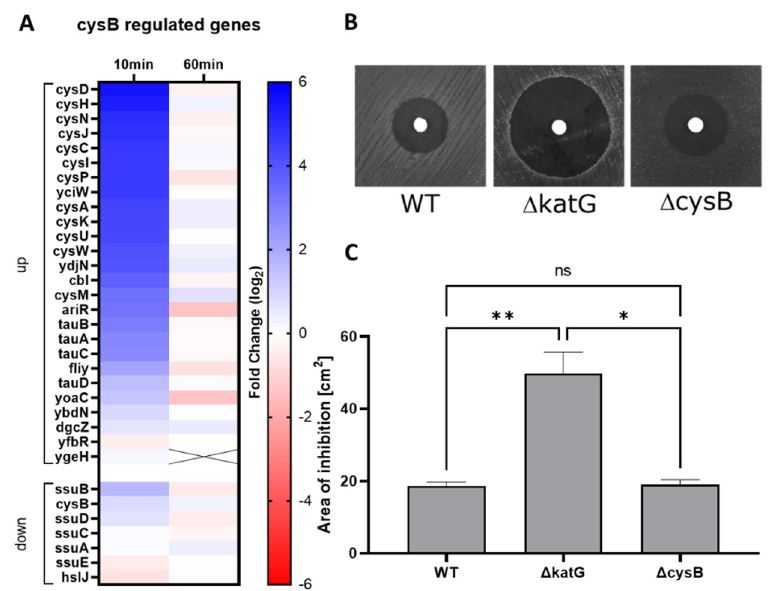
Figure 6. Dysregulation of the sulfur assimilation and cysteine biosynthesis pathways; ( A ) Heatmap of the differential expression of genes of the CysB regulon (fold-change (log 2 )); ( B ) Disk diffusion assay performed with 10 µ L of 1 M H 2 O 2 , showing one representative experiment of the WT and the cysB and katG deletion mutants; ( C ) Zone of bacterial growth inhibition assessed by the disk diffusion assay on the WT and the cysB and katG deletion mutants (mean+/ − SD; N = 6; statistical test was Kruskal-Wallis with Dunn multiple comparison, ns: p > 0.05, *: p ≤ 0.05, **: p ≤